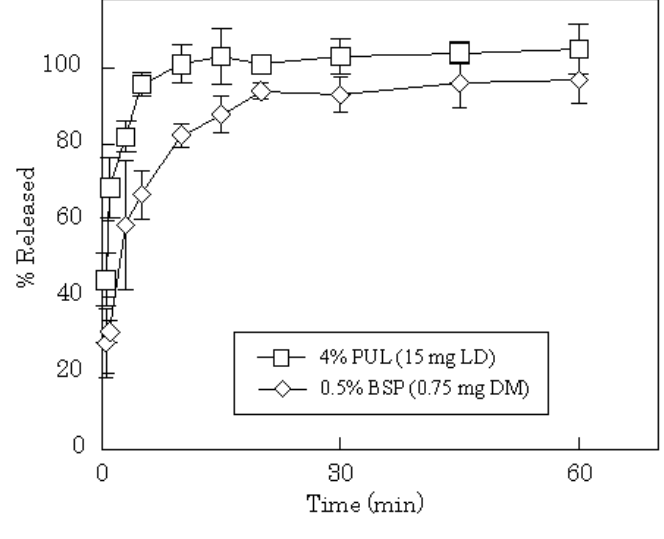
Figure 5. Release profiles of LD and DM from FDFs in phosphate-buffered saline (pH 7.4).